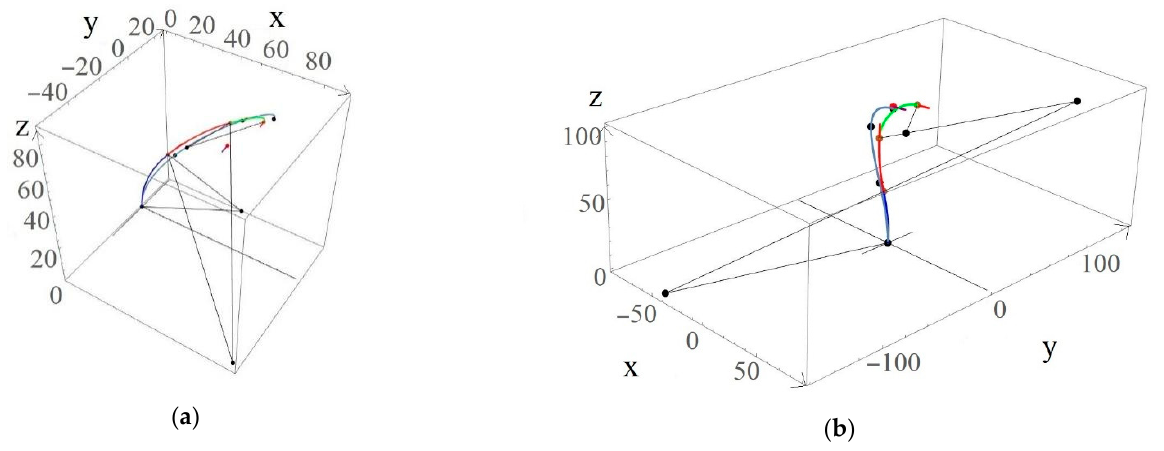
Figure 20. Bent spine views with different endpoint direction unit vector (cid:1815)(cid:3549) (cid:2928) (purple vector) and (cid:1833) goal point (redpoint) coordinates’ representation. The light blue curve is an estimated robot spine curve, and calculated robot segment arc curves are in blue, red, and green: ( a ) robot spine view when (cid:1833) = (50, 0,63) and (cid:1815)(cid:3549) (cid:2928) = (0.254, −0.889,0.381) ; ( b ) robot spine view when (cid:1833) = (0, 0, 100) and (cid:1815)(cid:3549) (cid:2928) = (0.254, 0.889, −0.381) .